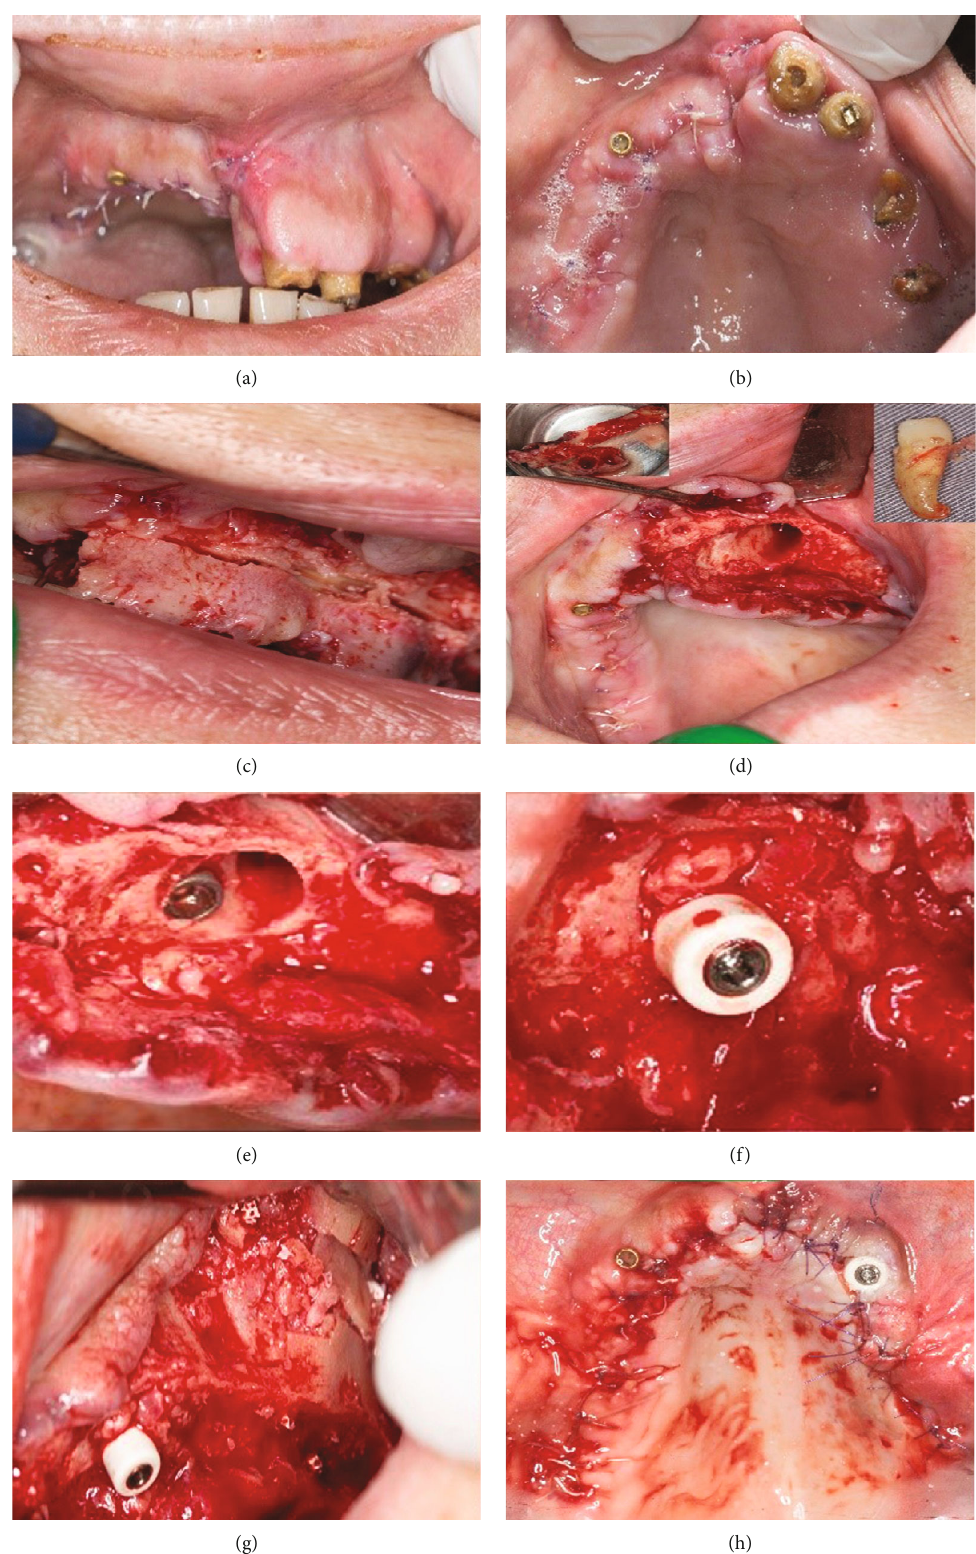
Figure 3: Right hemimaxilla: (a, b) clinical situation 2 weeks following left hemimaxilla resection and immediately before proceeding with the right hemimaxilla. (c) Segmental osteotomy of the right hemimaxilla. (d) Impacted canine extraction. (e) Implant insertion in the remaining canine socket. (f) Jumping space fi lled with autogenous resected alveolar process. (g) Sinus fl oor elevation. (h) Occlusal view of the postoperative clinical